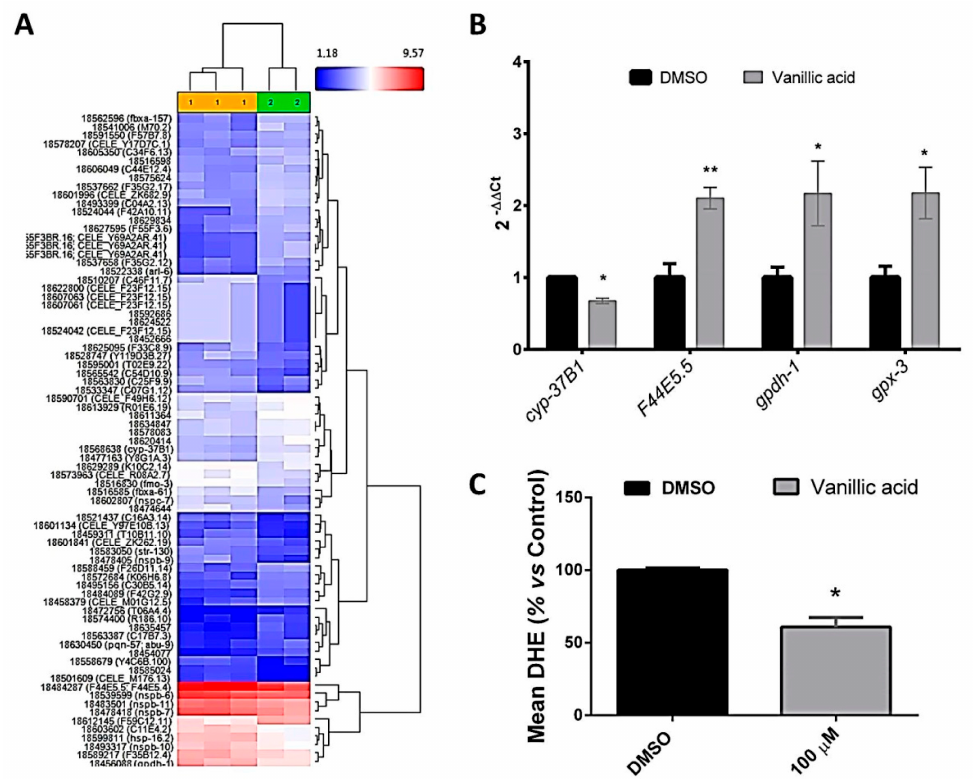
Figure 5. Gene expression microarray comparison of vanillic acid (100 µ M)-treated worms vs. DMSO control worms. ( A ) Hierarchical clustering analysis of vanillic acid (yellow) and DMSO (green) samples. ( B ) qPCR analysis of genes di ff erentially expressed in microarray analyses. Results are expressed as the fold-di ff erence expression levels of each gene in the vanillic acid-treated group compared with the DMSO control group, calculated with the 2 − ∆∆ Ct method. Significance refers to the e ff ect of vanillic acid with respect to DMSO control worms (Wilcoxon test, * p < 0.05; ** p < 0.01). ( C ) Quantification of the ROS production (measured by DHE) in vanillic acid-treated worms compared with DMSO control worms (mean ± SD relative to DMSO-treated worms). Significance refers to the e ff ect of vanillic acid with respect to DMSO control worms (Student’s t -Test, * p <